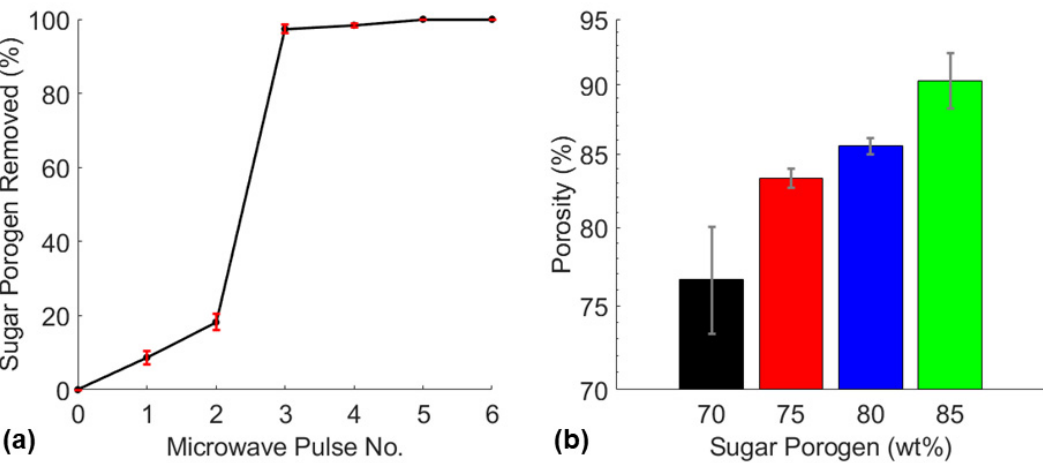
Figure 2. ( a ) Sugar porogen removed after each microwave pulse of CNT3P70 sponges and ( b ) the varying porosities of CNT3P70, CNT3P75, CNT3P80, and CNT3P85 sponges.